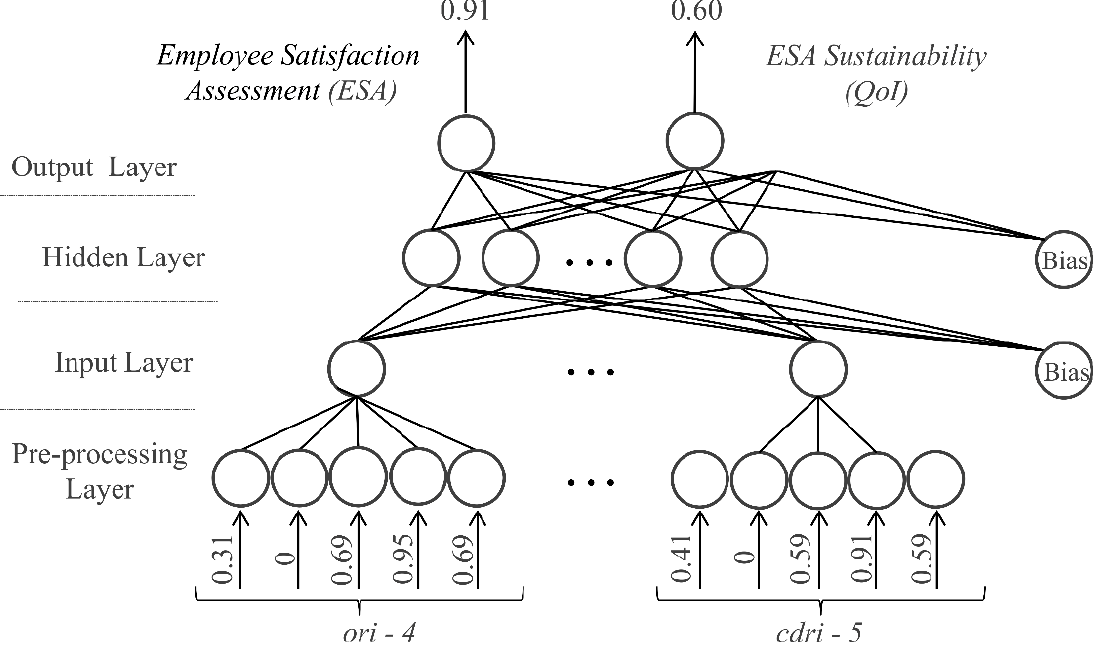
Figure 5: A creative view of the ANN topology for ESA assessment and a measure of its Sustainability (QoI) for the Best-case